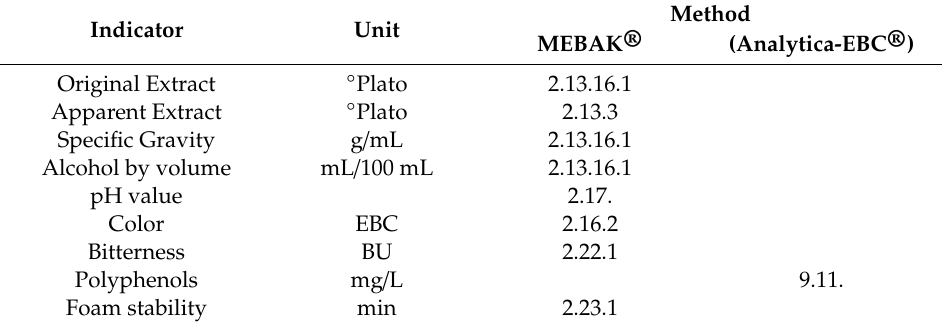
Table 1. Methods and the abbreviations used for the analysis of physical-chemical quality indicators in chosen